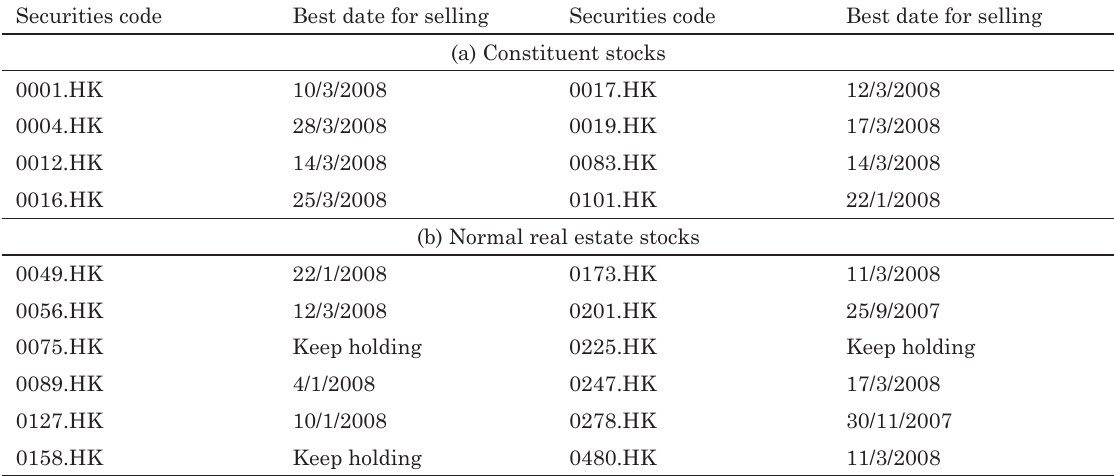
table 6. The latest best selling time of Hong Kong real estate